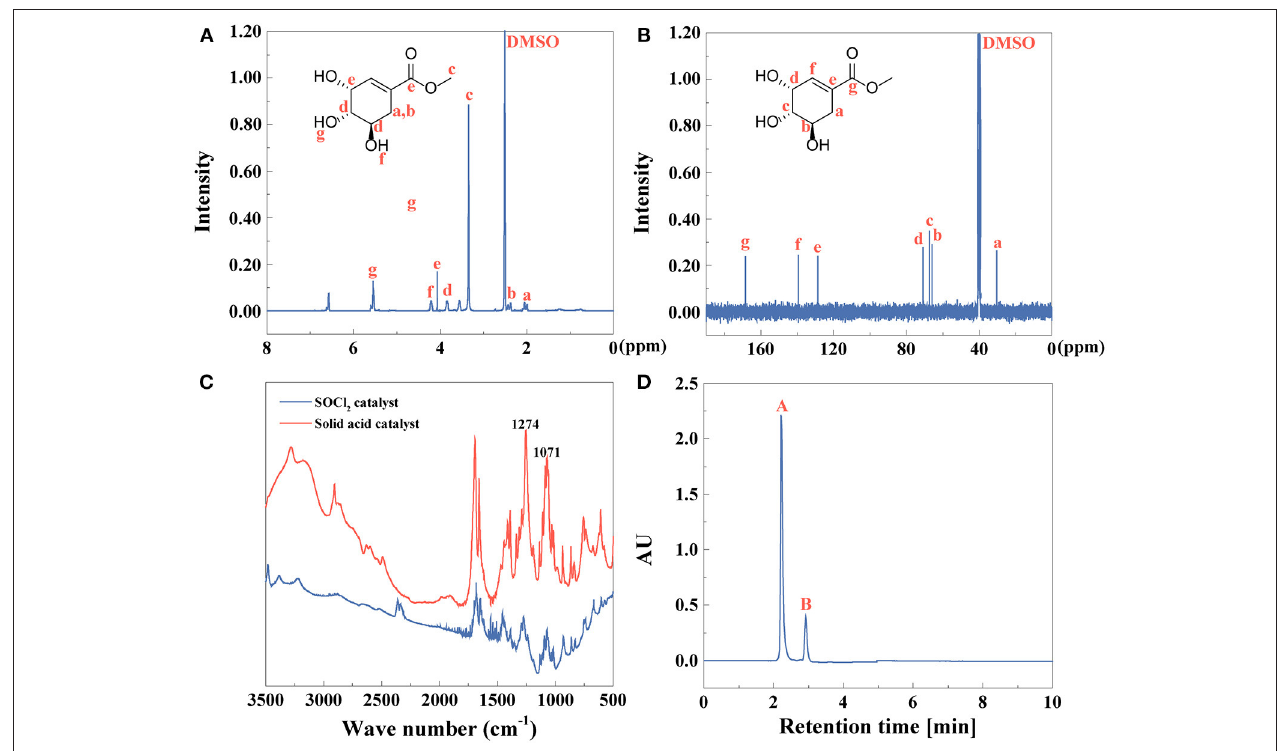
TABLE 1 | Antibacterial activity of star anise extractives.